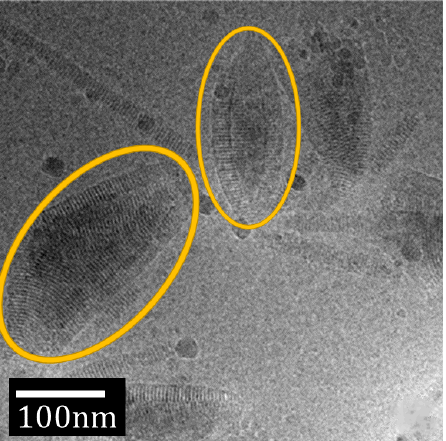
Figure 9. Self-assembled structures of PEG 114 -b-PAChol 60 prepared in dioxane/water (14:86) showing the notable smectic stripes decorated on nanocylinders and ellipsoids (circled). Reprinted with permission from Jia et al., Polymer , 2011 , 52 , 2565–2575